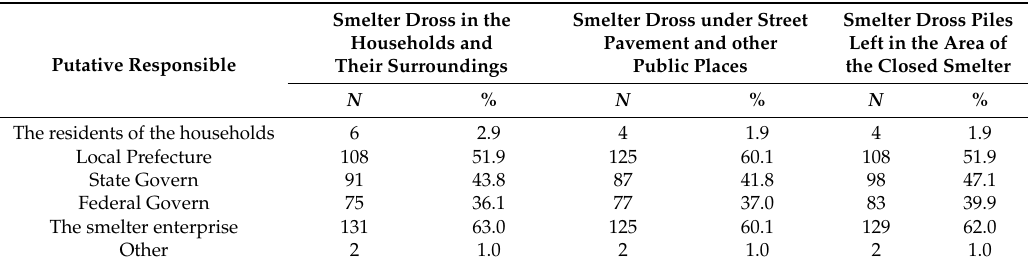
Table 4. The putative responsible entity for taking actions to manage the smelter dross according to the opinion of 208 residents in Santo Amaro City,